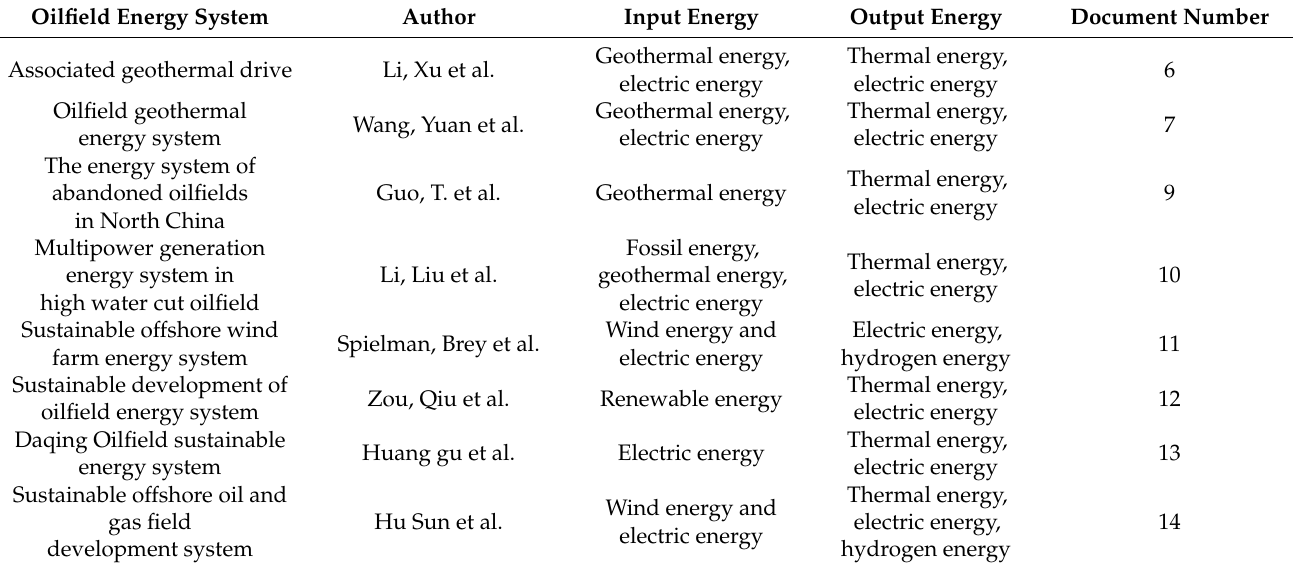
Table 1. Literature summary of the oilfield energy system.